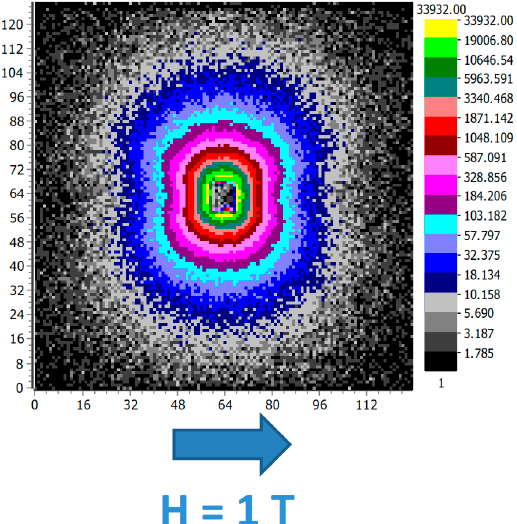
Figure 2. 2D small-angle neutron scattering (SANS) pattern (neutron counts) of the un-irradiated Eurofer97 reference sample, measured with λ = 6 Å at 2 m sample-to-detector distance; external magnetic field direction is horizontal in the plane of the figure.